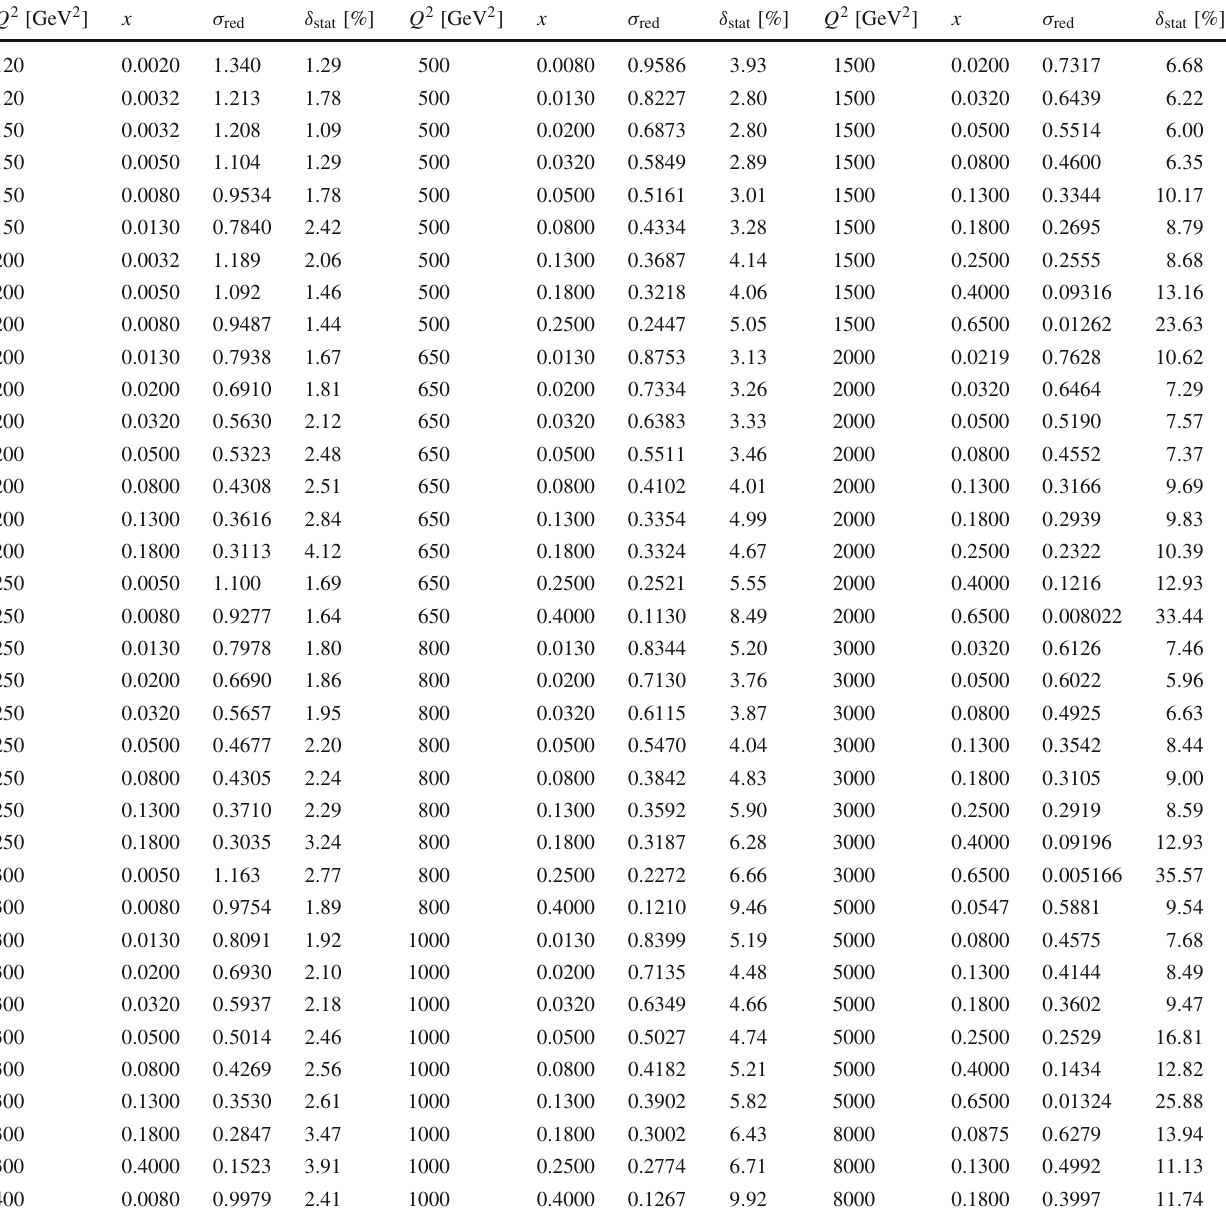
Table 7 The NC e − p reduced cross section σ red with lepton beam polarisation P e = 36 . 0% with their statistical ( δ stat ) uncertainties. The full uncertainties are available in Ref. [58], while the respective cross section values are updated according to Sect. 3 and Ref.